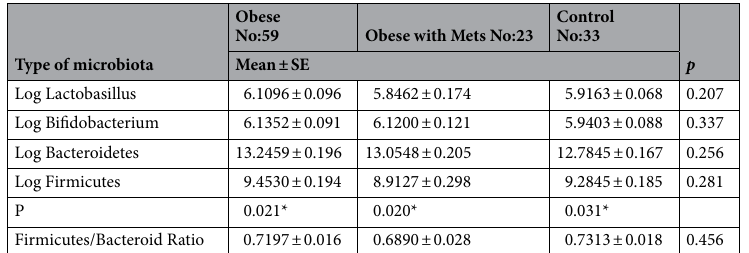
Table 3. Mean ± SE of the number and types of Microbiota among the three groups. *Significant at p <